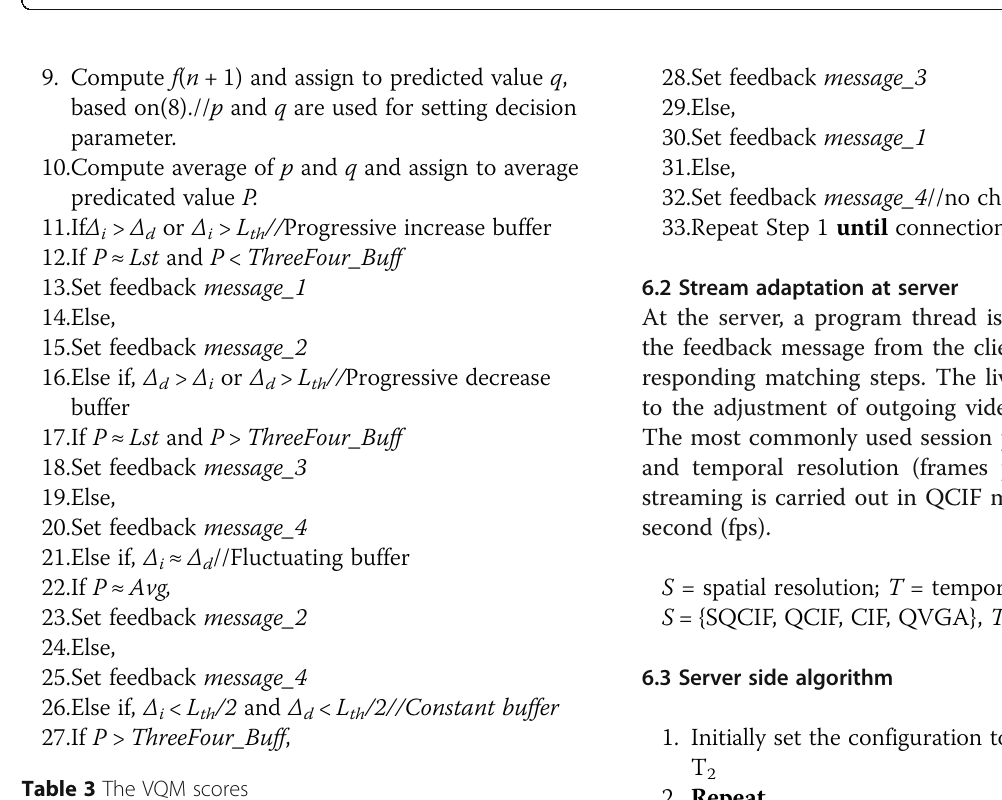
Fig. 7 The SSIM comparsion. The structural similarity index corresponing to selected consecutive frames is normalized between 0 and 1 for the three techniques discussed